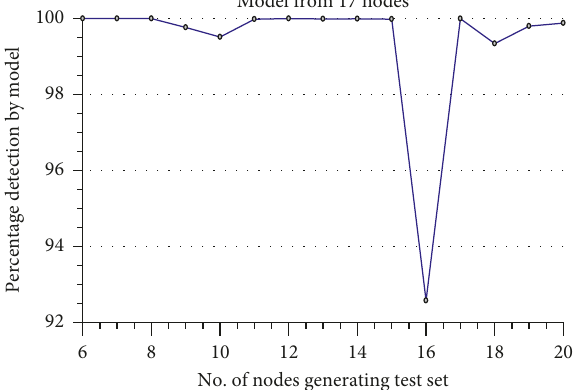
Figure 16: Simulation results for 14 nodes.